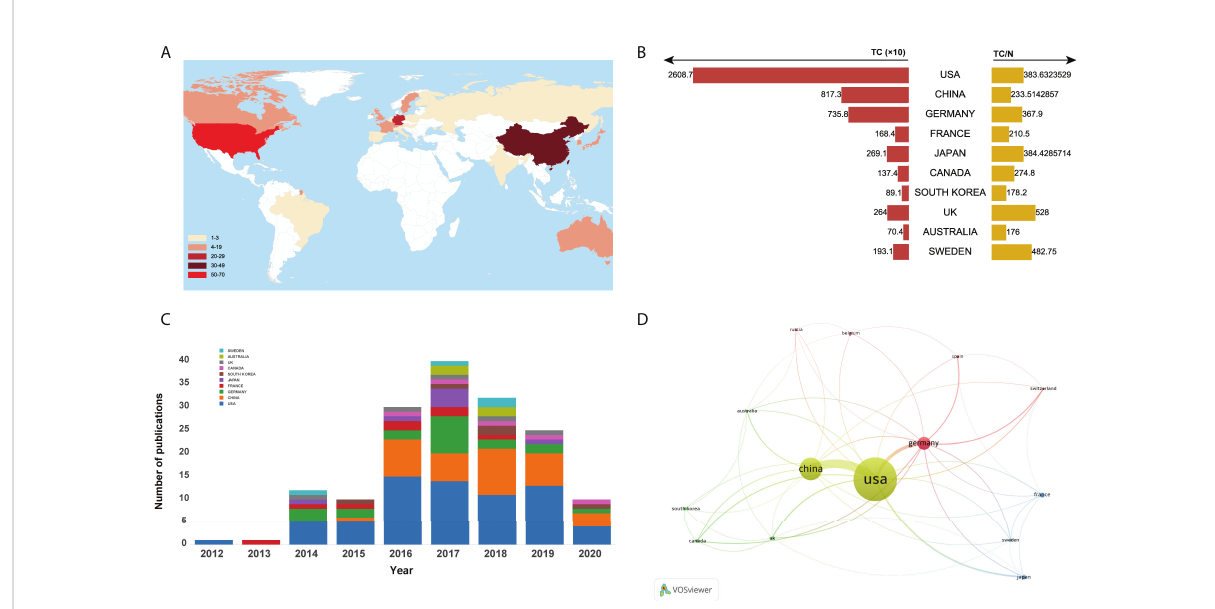
FIGURE 3 (A) Number of top-cited publications by countries/regions. (B) Total citations and average citations per document of top 10 most proli fi c countries/regions. (C) The number of annual publications of top 10 countries/regions on ferroptosis research from 2000 to 2020. (D) Network visualization map of country co-authorship analysis.